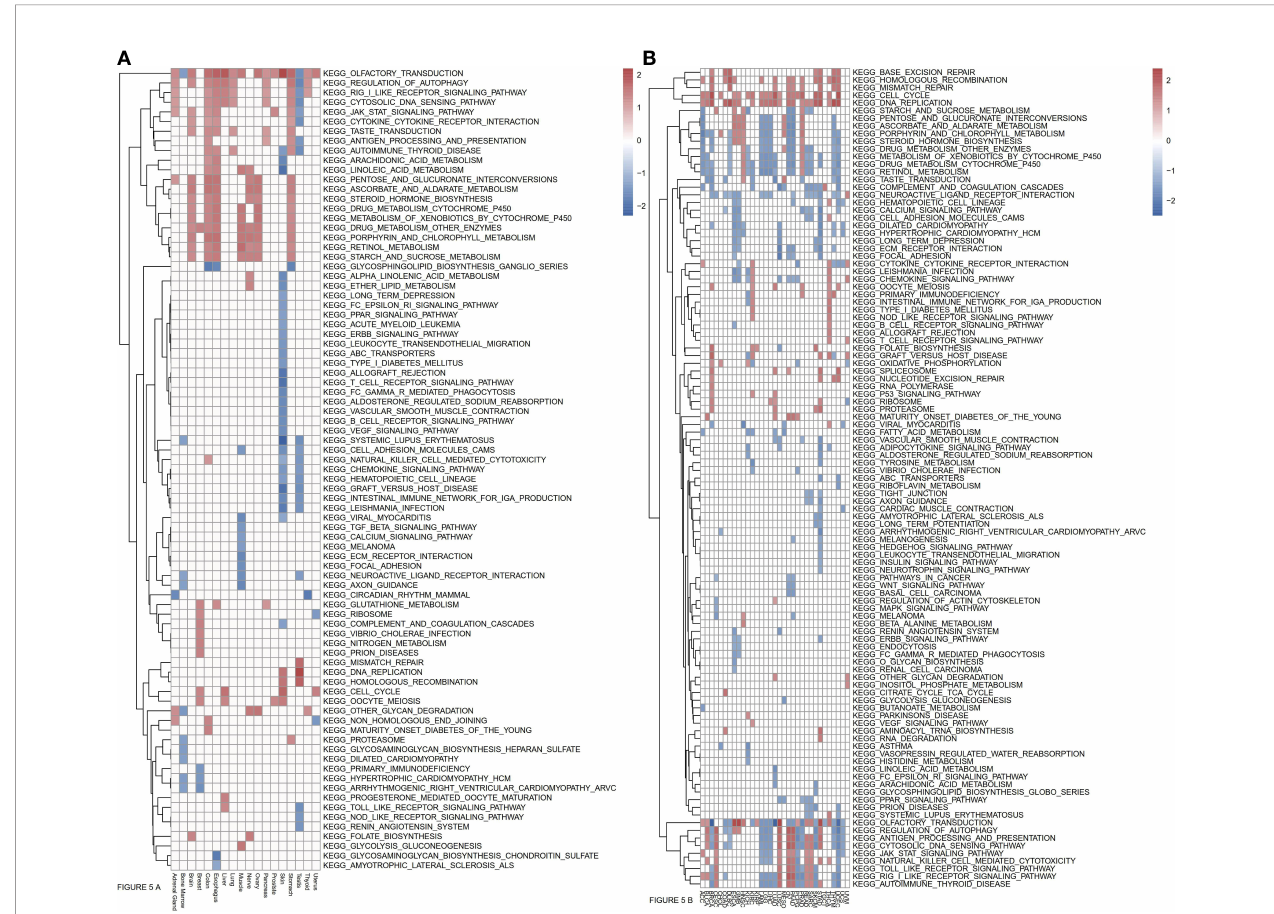
FIGURE 5 | (A) Relationships between ASF1B and KEEG pathways in normal tissues from GTEx analyzed by GSEA. (B) Relationships between ASF1B and KEEG pathways in cancers from TCGA analyzed by GSEA. (NES ≥ 1.0,